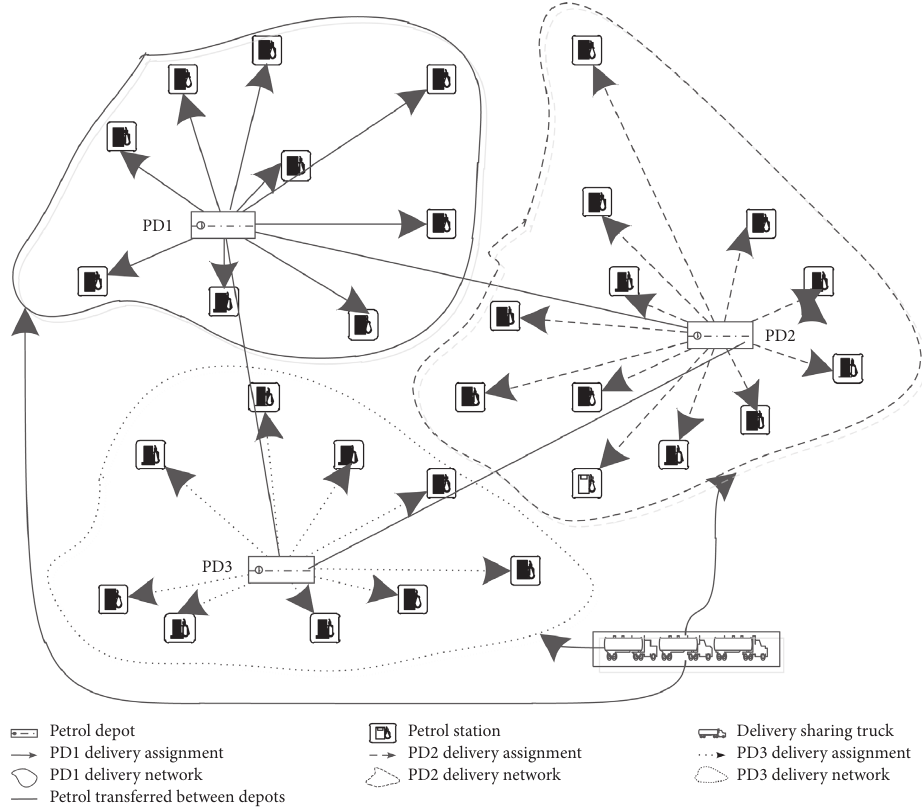
Figure 2: Cooperative petrol distribution